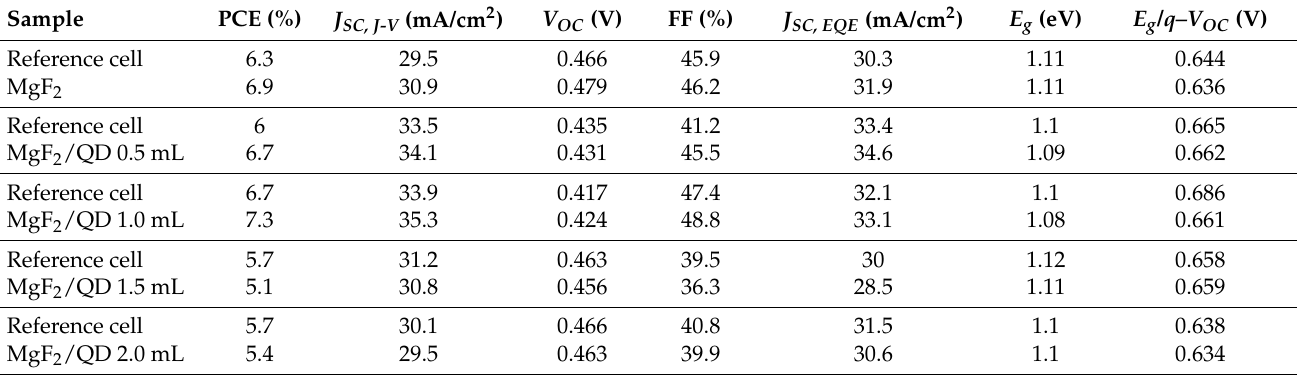
Figure 7. ( a ) External quantum efficiencies (EQEs) and ( b ) J-V characteristics of the CZTSSe solar cells fabricated with various LDS layers. Table 2. Parameters of the CZTSSe solar cells obtained from the EQEs and J-V characteristics before and after LDS layer deposition 1